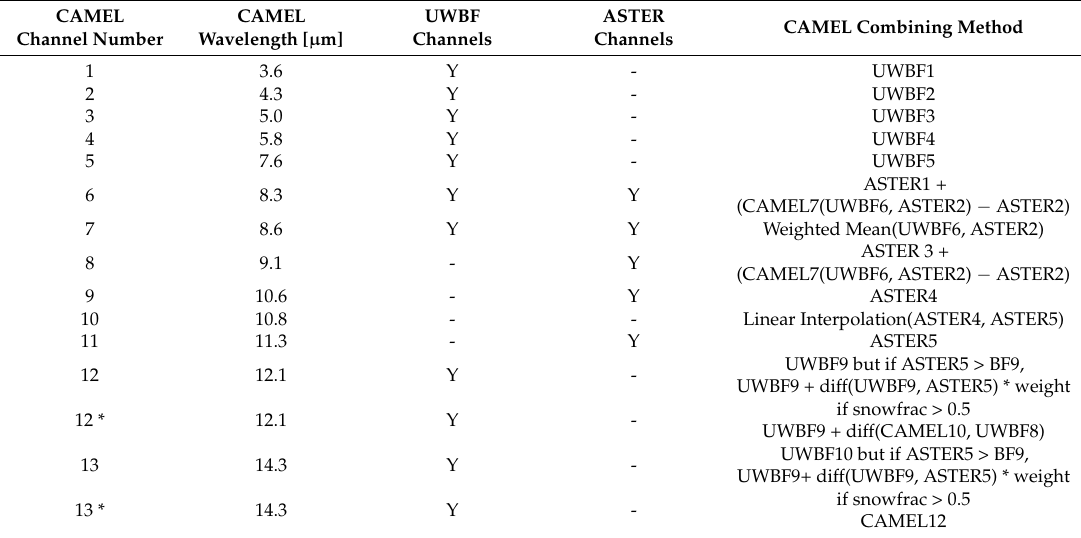
Table 1. Method to create CAMEL emissivity for the 13 hinge